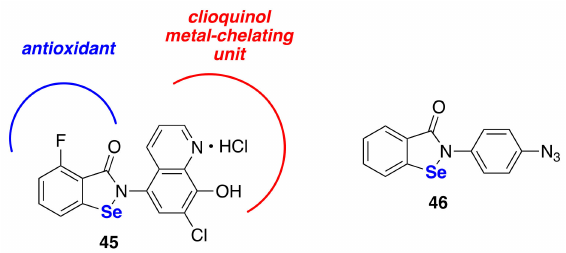
Figure 12. Structure of anti-AD